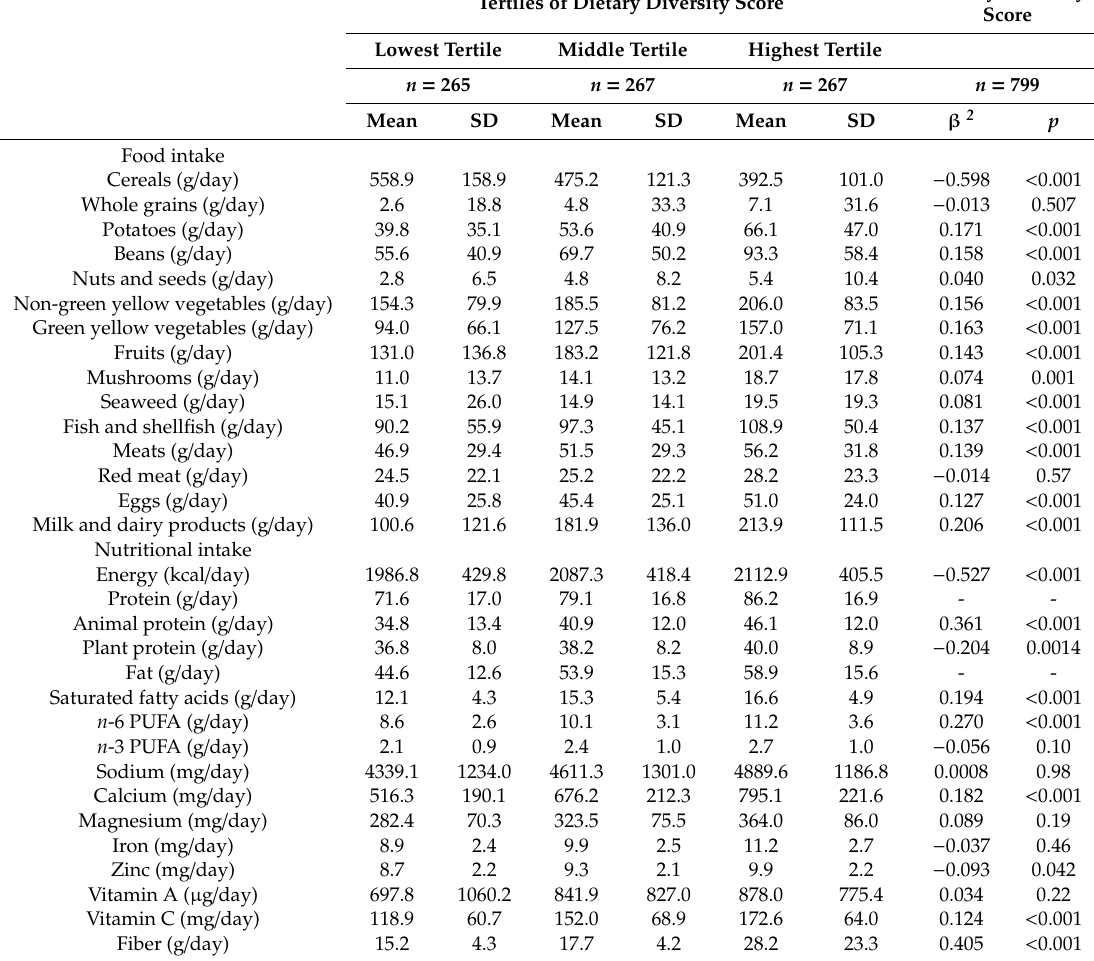
Table 2. Baseline dietary and nutritional intakes according to the tertiles of dietary diversity score and association between dietary and nutritional intakes and dietary diversity score by multivariate linear regression